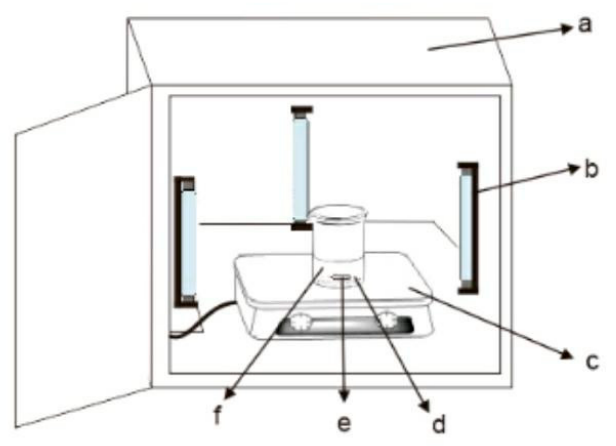
Figure 12. A set of apparatus used for Pb(II) photo-oxidation processes composed of: ( a ) melamine box, ( b ) visible or UV lamps, ( c ) magnetic stirrer plate, ( d ) photocatalyst powder, ( e ) magnetic stirrer bar and ( f ) sample solution .